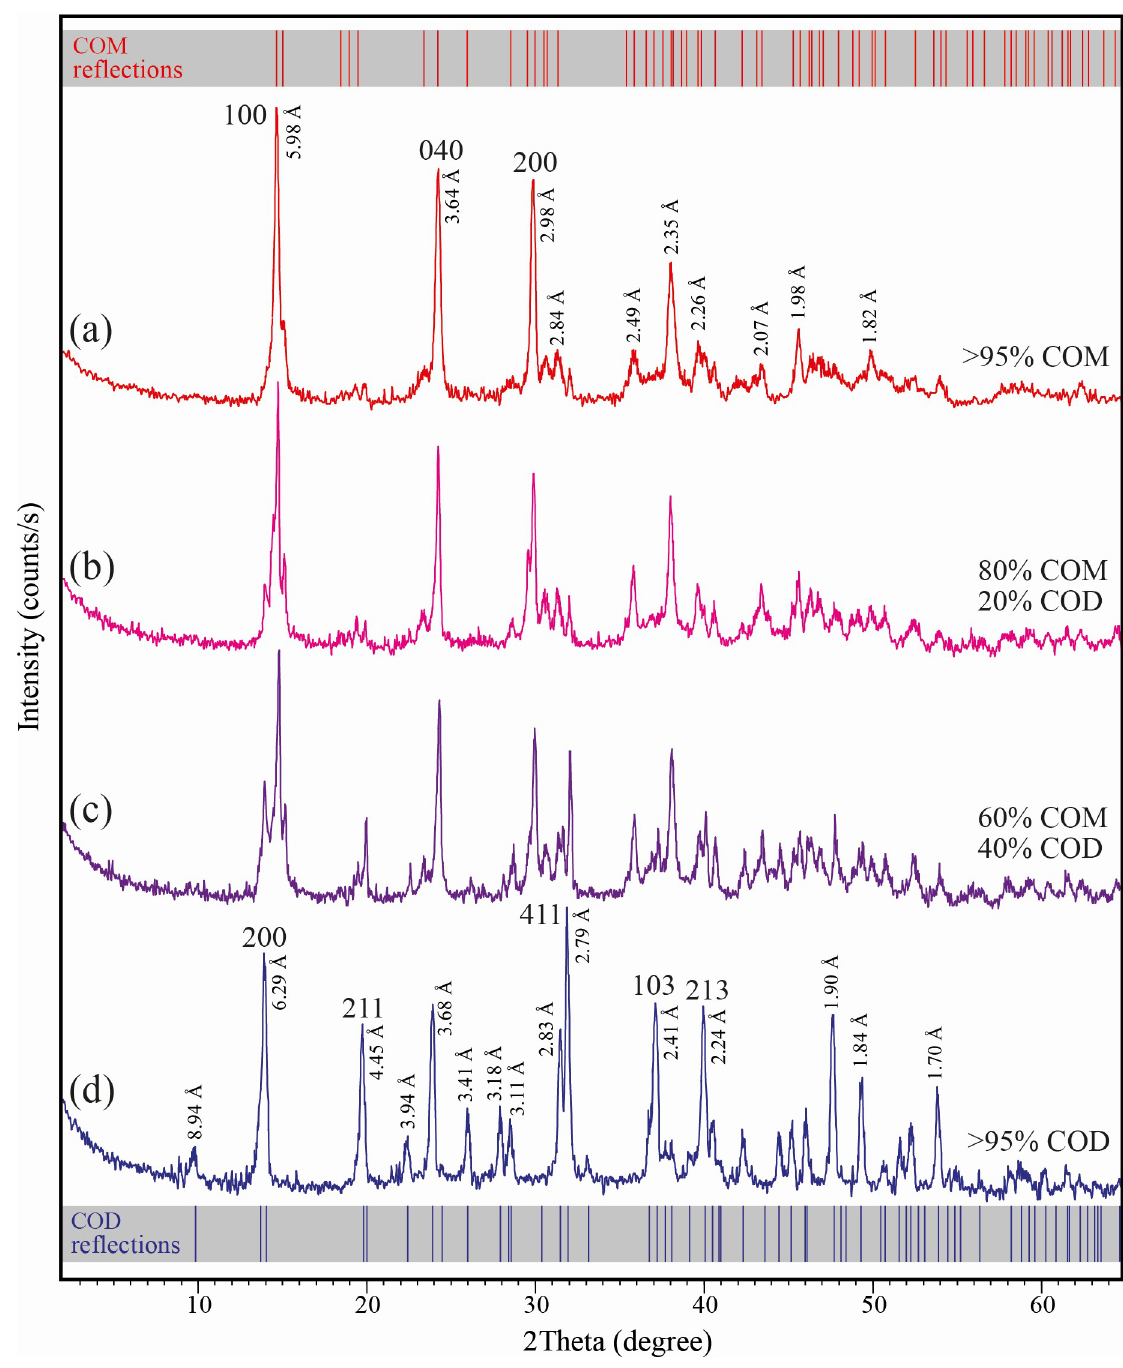
Fig 5. XRPD diffraction diagrams of calcium oxalate monohydrate (COM) and dihydrate (COD) crystals. The crystals were grown in the absence and presence of C . officinarum AE: (a) COM crystals obtained in absence of AE.; (b, c) COM and COD crystals obtained in the presence of AE 200 μ g dw/ml (b) and 500 μ g dw/ml (c); (d) COD crystals obtained in the presence of AE 1000 μ g dw/ml. D values and indices of the main reflections are reported. The standard diffraction spectra of COM (upper grey bar, reference code 00-016-0379) and COD (lower grey bar, reference code 01-075-1314) crystals are also shown for comparison.